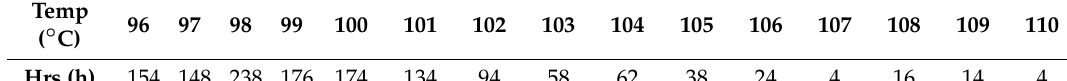
Table 5. Time series of conductor temperature and exposure time.